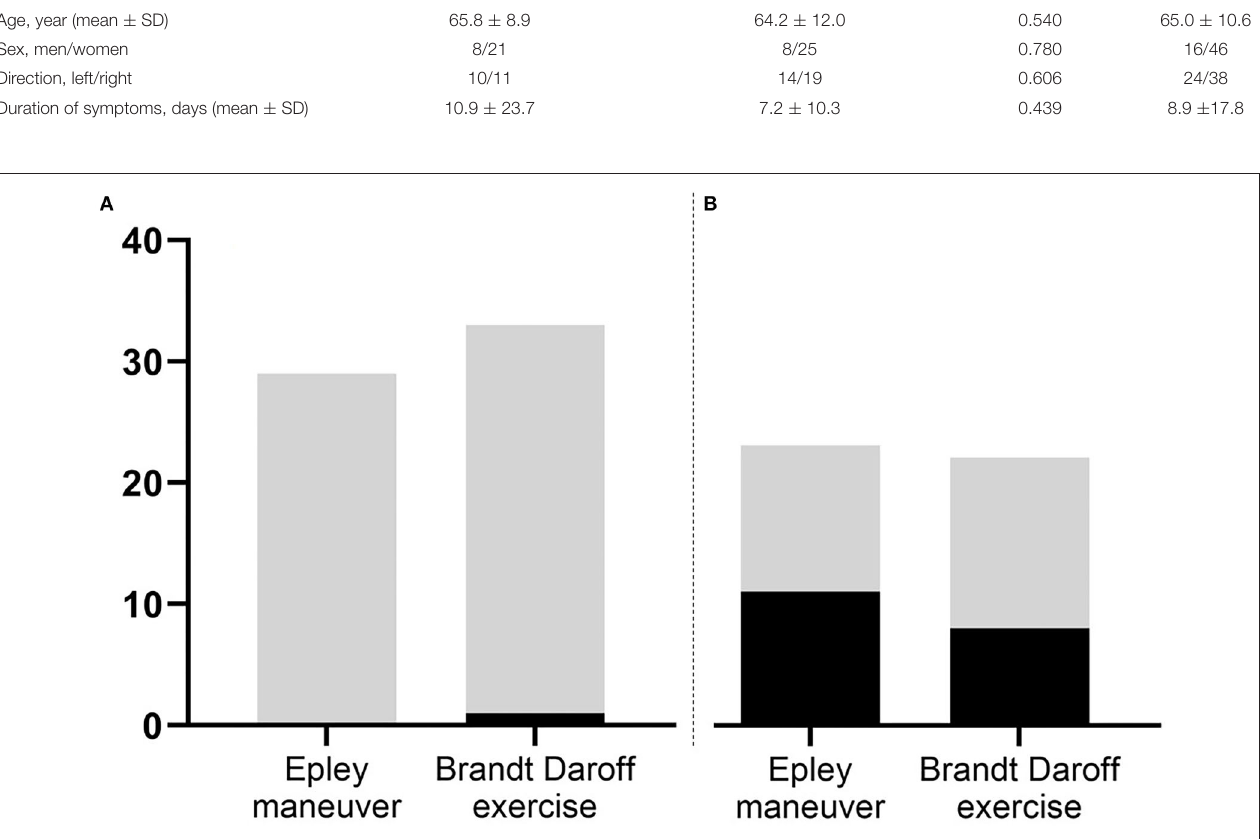
FIGURE 2 | The success rate of Epley maneuver and Brandt-Daroff exercise. (A) On the visit day, only one patient in Brandt-Daroff exercise group shows the resolution of positional nystagmus. (B) At 1 week, 48% in Epley maneuver group and 36% in Brand-Daroff exercise group show the resolution of positional nystagmus without difference between two groups ( p = 0.436, χ 2 -test). Vertical axis means the number of patients. The patients without nystagmus during Dix-Hallpike maneuver are revealed as black column, the gray column means